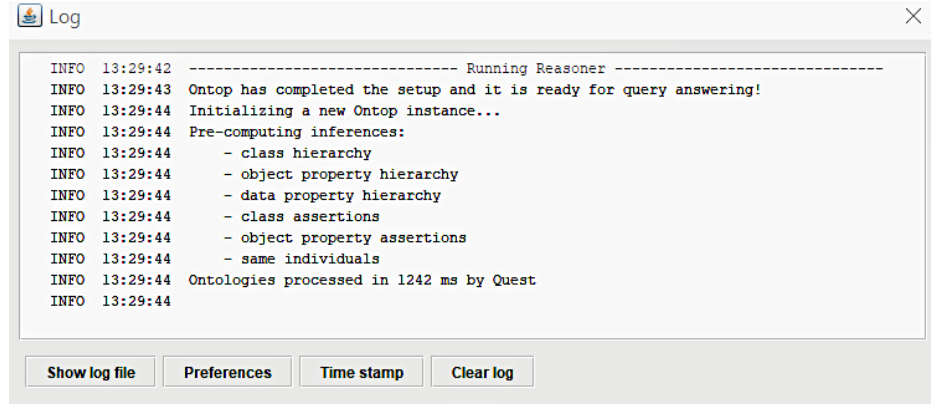
Figure 9. The console displaying no inconsistency or incorrectness messages when starting the Ontop stream